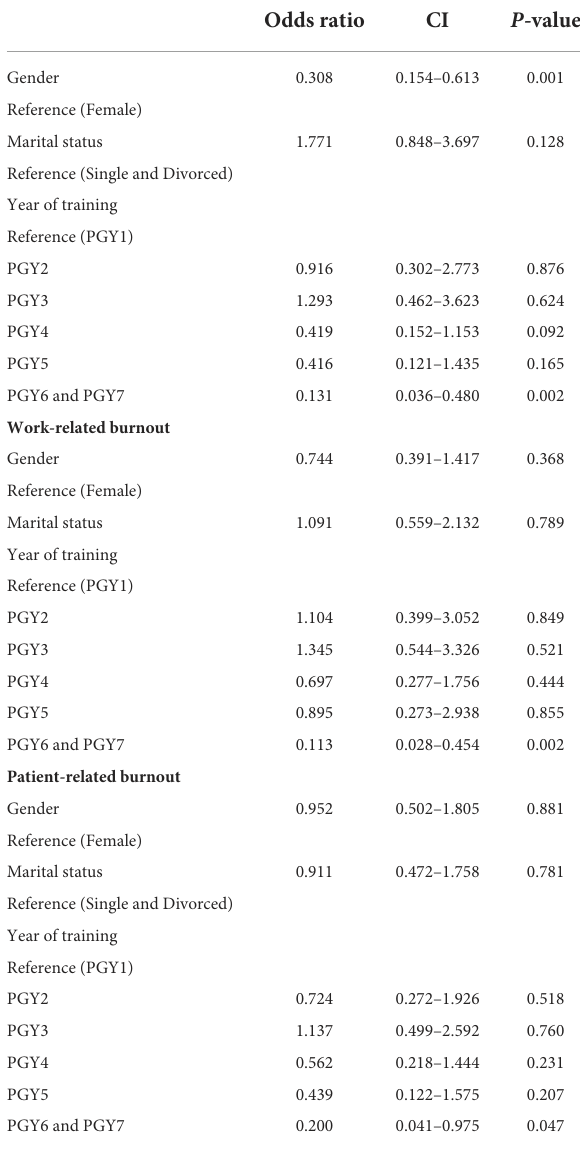
TABLE 5 Binary Logistic Regression for the scales and gender, marital status, and year of